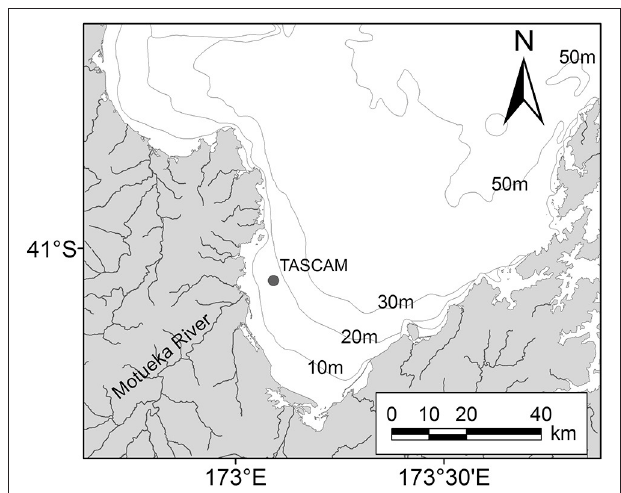
FIGURE 2 | Map showing the location of the TASCAM (dot) monitoring buoy in Tasman Bay and the Motueka River to the south-east of the buoy. Bathymetric depth contours also shown (gray